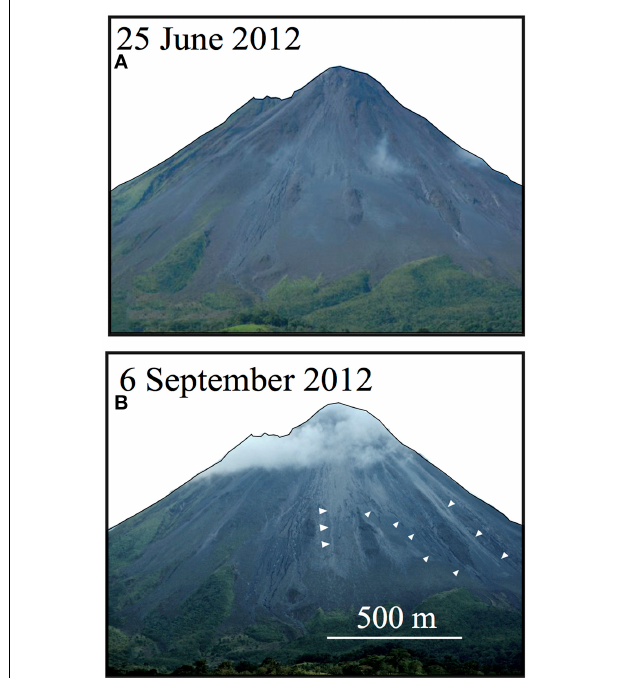
FIGURE 2 | (A) Photograph of Arenal taken on 25.06.2012 from the northwest, viewing direction indicated by the arrow on Figure 7 . (B) Photograph taken from the same location the day after the Nicoya Earthquake (06.09.2012). Changes to surface textures are indicated by white triangles.